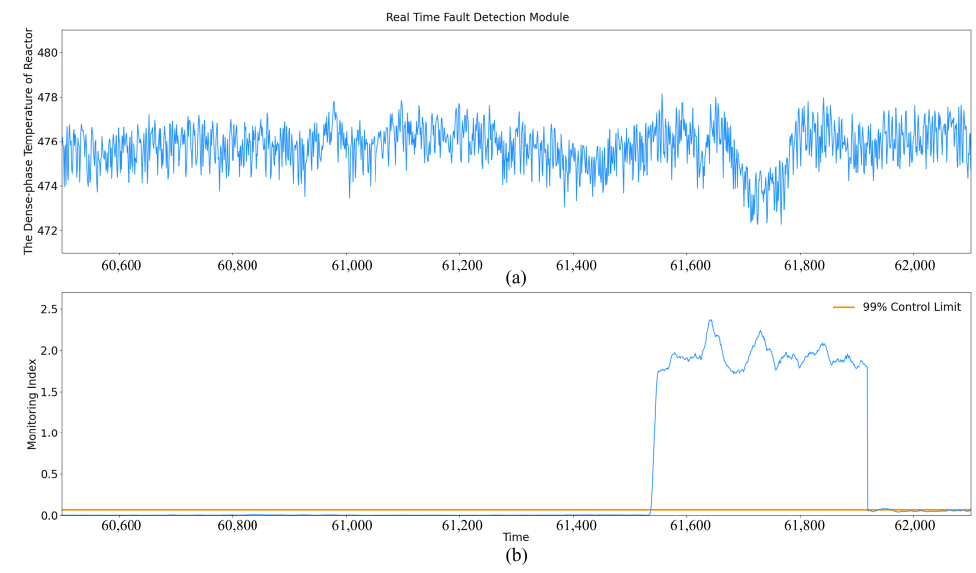
Figure 15. Process monitoring result of the proposed method on case three: (a) Original data of the key variable; (b) Fault detection results.